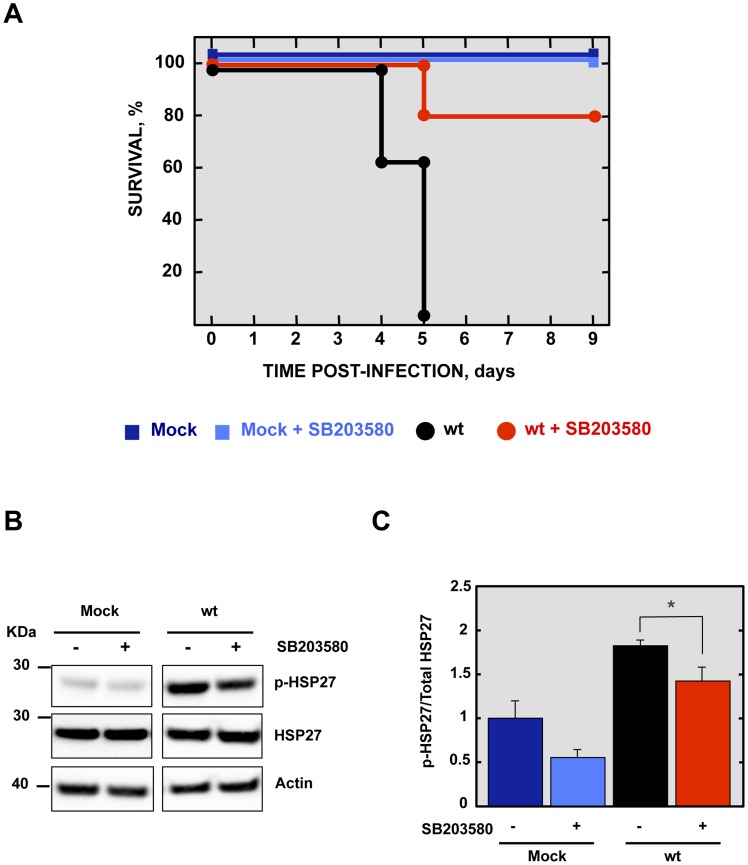
Effect of p38 MAPK inhibitor in rSARS-CoV-MA15-infected mice.16-week-old BALB/c mice were mock-infected or inoculated intranasally with 100,000 pfu of wt virus. At 4 hpi and every 12 h from days 1 to 8, mock pfu of wt virus. At 4 hpi and every 12 h from days 1 to 8, mock hpi and every 12 h from days 1 to 8, mock h from days 1 to 8, mock-infected and wt-infected mice were intraperitoneally injected with SB203580 (6 mg mg/kg of body weight/day). (A) Animals were monitored daily for mortality. Data represent three independent experiments with 5 mice per group. (B) The active phosphorylated (p-HSP27) and total HSP27 in lungs of three infected mice per condition were evaluated by Western blot analysis. (C) Phospho and total HSP27 amounts were quantified by densitometric analysis. The graph shows the phosphorylated HSP27/total HSP27 ratio at 2 dpi in lungs of mock dpi in lungs of mock-infected mice or mice infected with the parental virus, treated or not with SB203580. Error bars represent the means of three mice analyzed for each condition. Statistically significant data are indicated with one (P<0.05) asterisk.